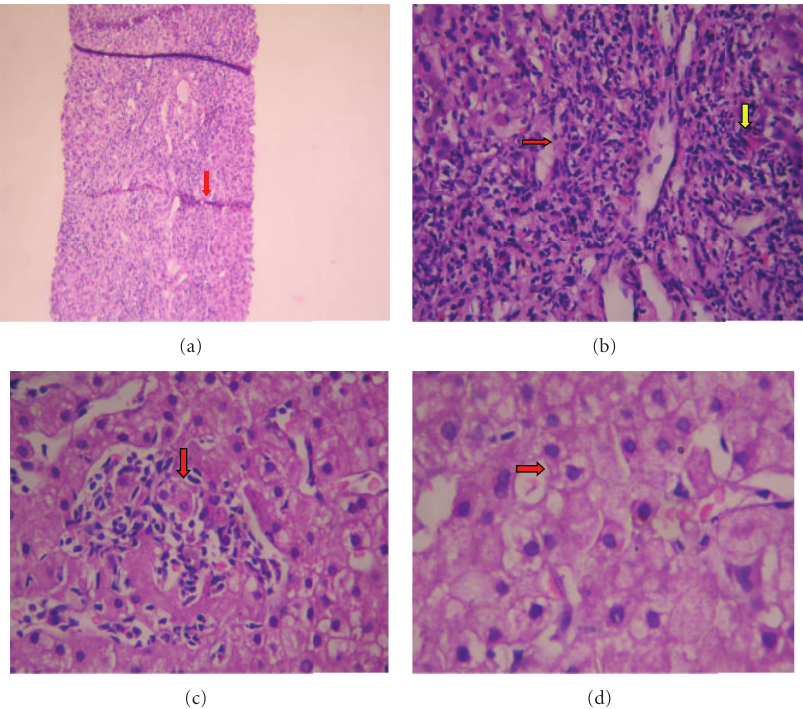
Figure 2: (a) Mild distortion of architecture by enlarged portal areas and bridging fibrosis/necrosis (red arrow) [Hematoxylin and Eosin Stain, 50x]. (b) Interface hepatitis (red arrow) and portal inflammation (yellow arrow) [Hematoxylin and Eosin Stain, 100x]. (c) Lobular inflammation (red arrow) [Hematoxylin and Eosin Stain, 150x]. (d) Hydropic hepatocytes with attempted rosette formation (red arrow) [Hematoxylin and Eosin Stain, 200x].